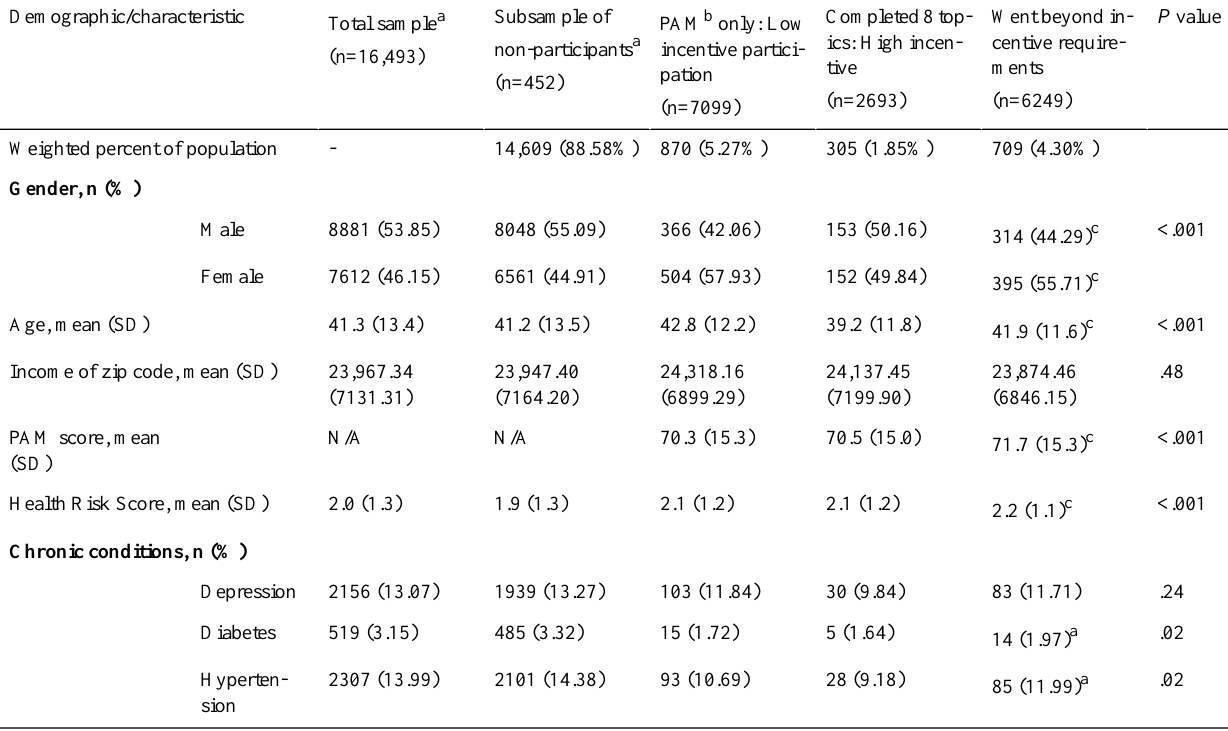
Table 1. Demographic and health characteristics of the study sample, by program participation level.